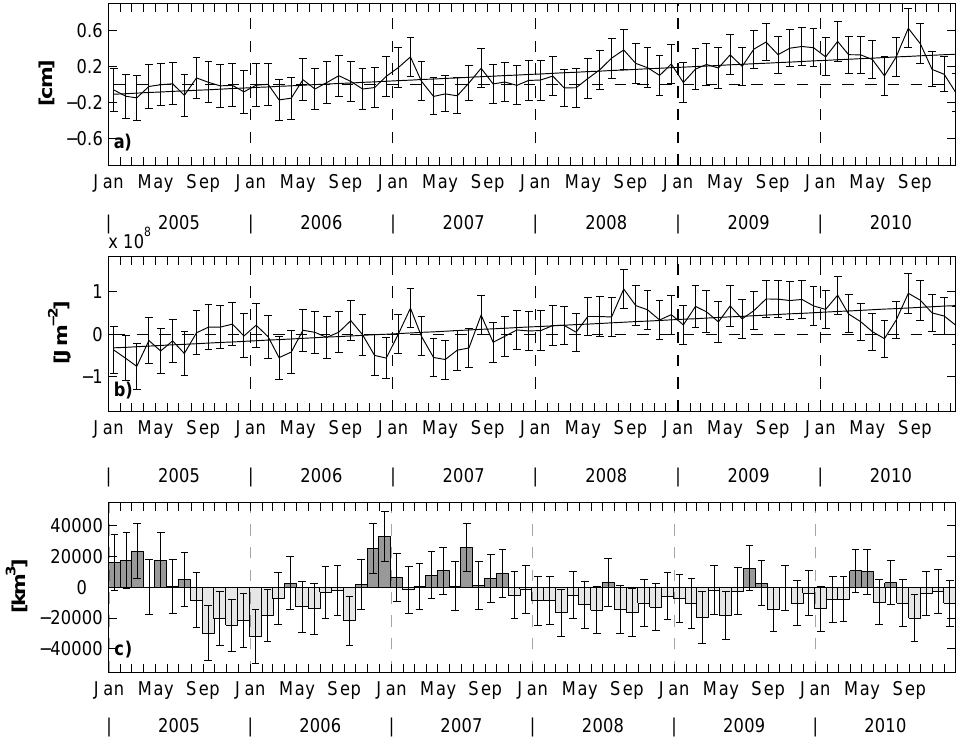
Fig. 5. Estimation of (a) GSSL, (b) GOHC and (c) GOFC. The calculation is based on the simple box averaging method applied to Argo measurements only. The 6-yr trends are of 0.75 ± 0.15mmyr − 1 , 0.54 ± 0.10Wm − 2 and − 80 ± 90km 3 yr − 1 , respectively. Error bars and trend uncertainties do not take into account remaining systematic errors in the Argo observing